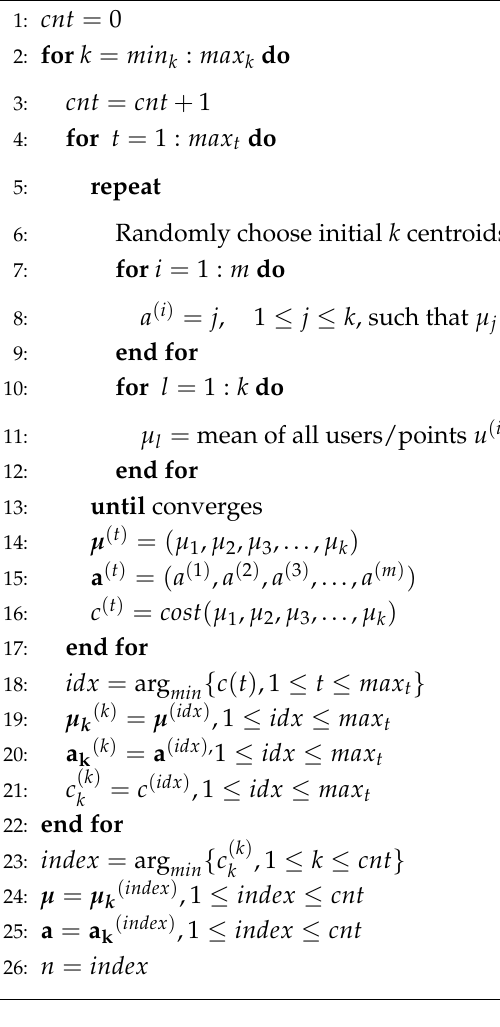
Algorithm 2 Users association clustering algorithm